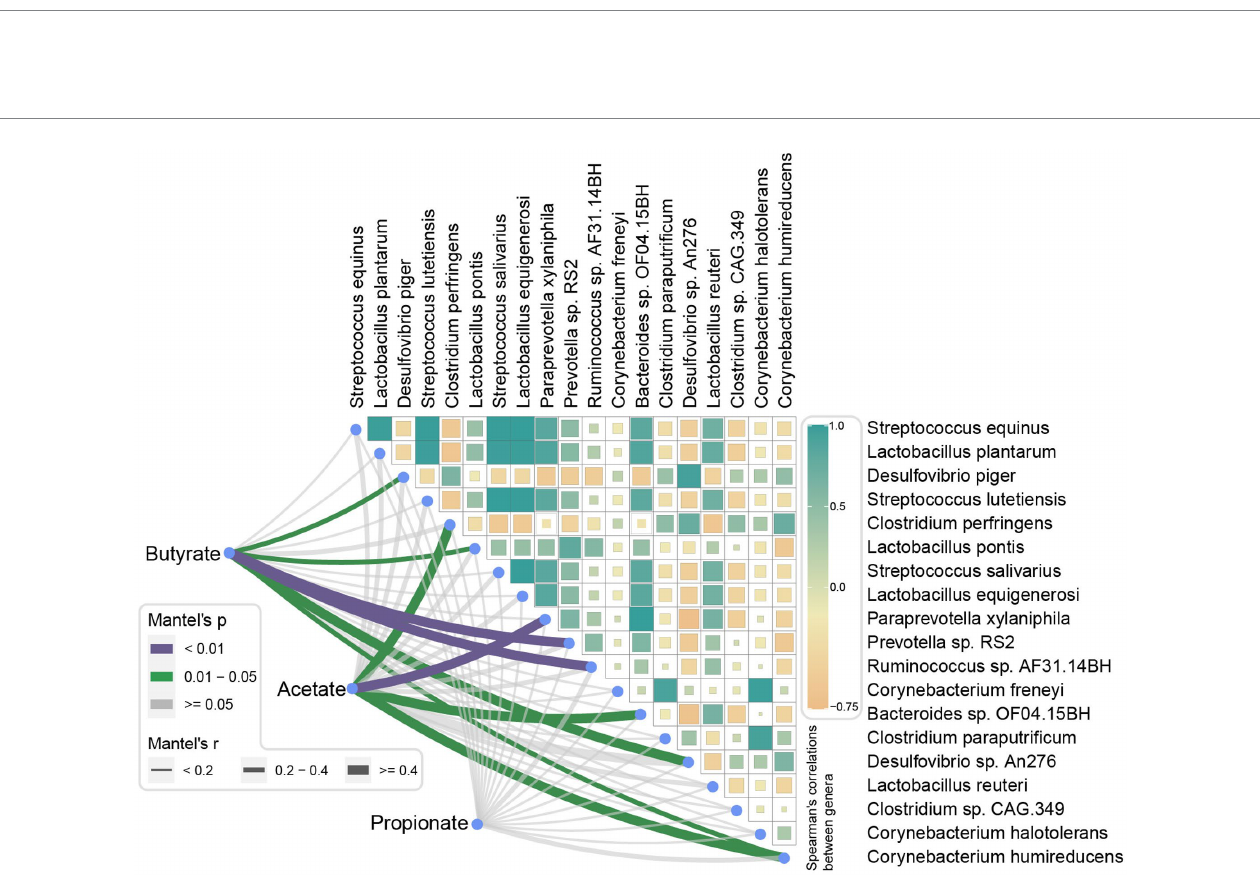
FIGURE 7 Correlations between short-chain fatty acid levels and finishing weight-associated species. Pairwise comparisons of finishing weight related-species are shown with a color gradient denoting Spearman’s correlation coefficient. Butyrate, acetate, and propionate were related to each microbial species by partial Spearman tests. Edge width corresponds to the Partial Spearman’s r statistic for the corresponding distance correlations, and edge color represents the statistical